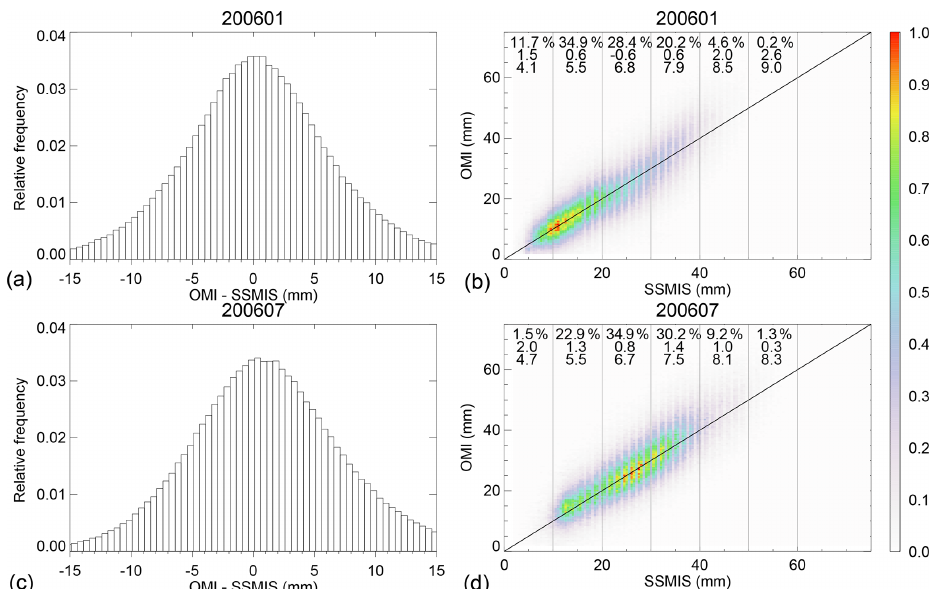
Figure 6. Comparisons between version 4.0 OMI and SSMIS over the oceans for (a, b) January 2006 and (c, d) July 2006. (a) The relative occurrence frequency of OMI–SSMIS (mm). (b) The normalized joint distribution of SSMIS versus OMI TCWV